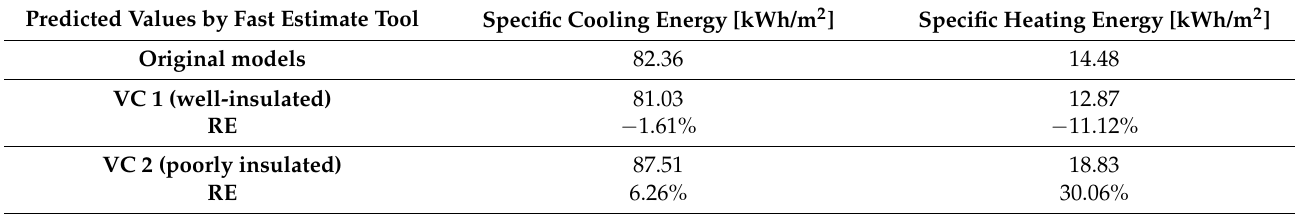
Table 12. Comparison between the predicted values of original models and VC 1 or